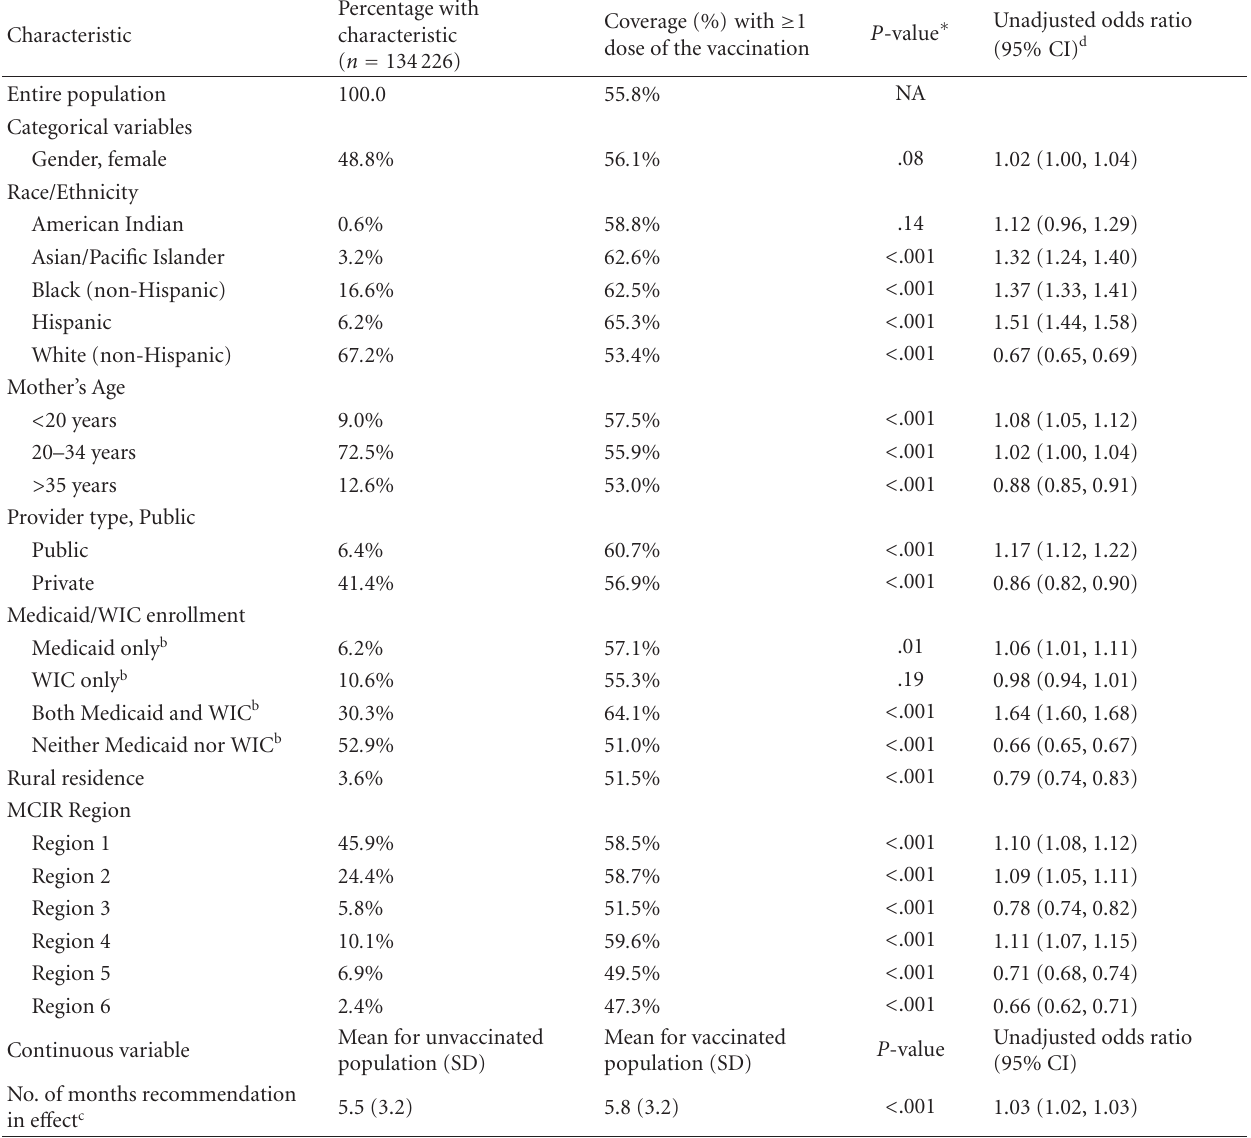
Table 1: Baseline characteristics, by hepatitis A vaccination receipt a